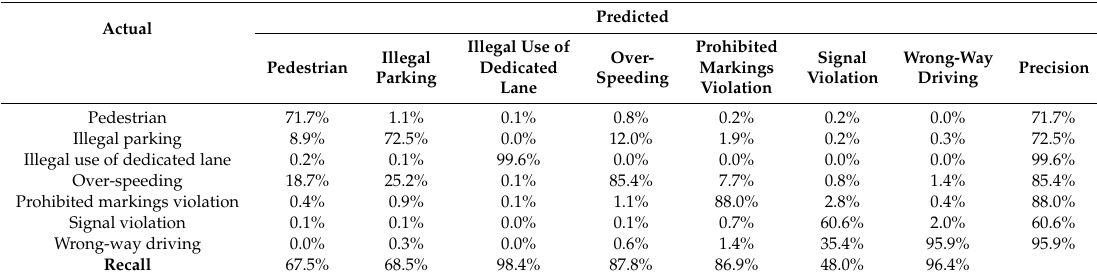
Table 3. Confusion matrix for AdaBoost model.